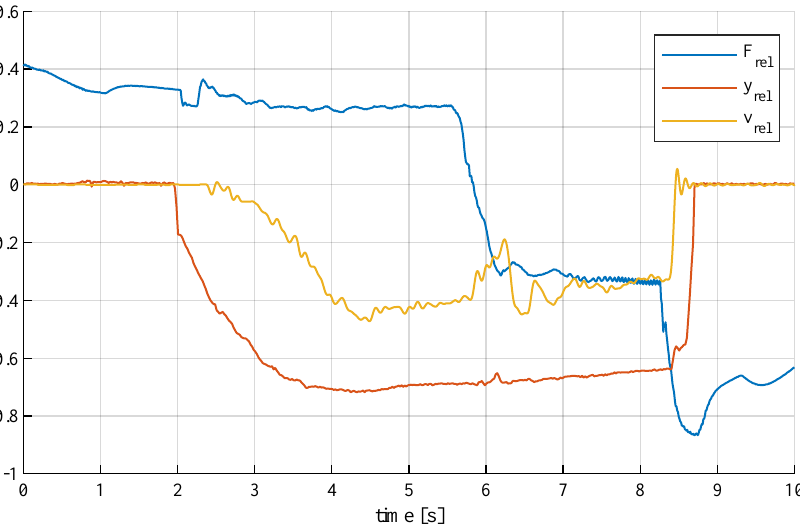
Figure 5. Acceptable speed behavior of displacement-controlled boom cylinders during mode switching that is forced by changing from resistive lowering to pushing up the front axis of the telehandler; 600 kN is the reference for the relative combined cylinder force F rel ; y signal; and 150 mm/s is the reference for the relative cylinder speed v rel